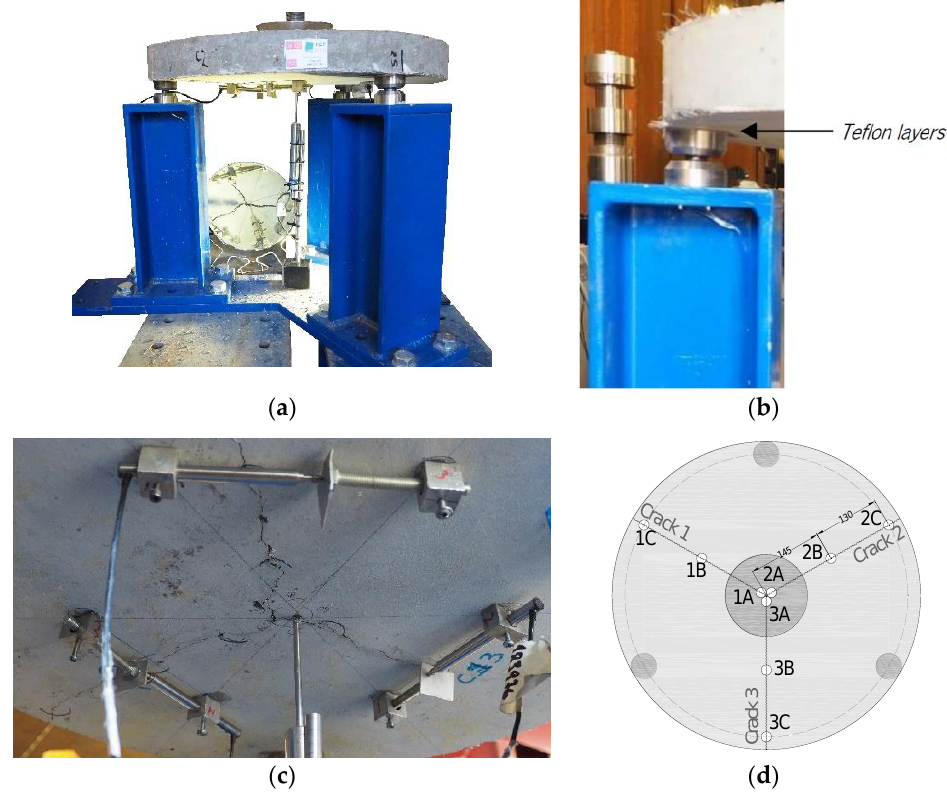
Figure 3. The round panel test supported on three points (RPT-3ps) setup: ( a ) the three pivots support system [3]; ( b ) connection between the panel and each pivot; ( c ) positions of the linear variable displacement transducers (LVDTs) for central deflection measurement and of LVDTs for crack width measurement; and ( d ) position of the crack width measurement with a USB microscope (“A”—At the center of the panel; “B”—At a distance of 145 mm from the panel center; “C”— At a distance of 275 mm from the panel center).